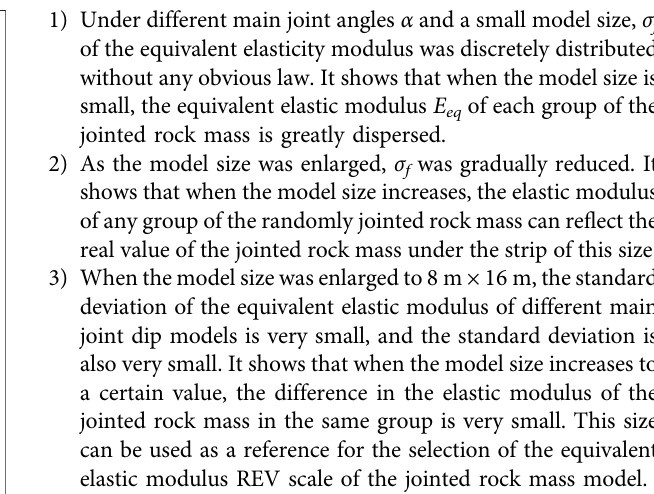
FIGURE 6 | Relationship between the equivalent elasticity modulus and model